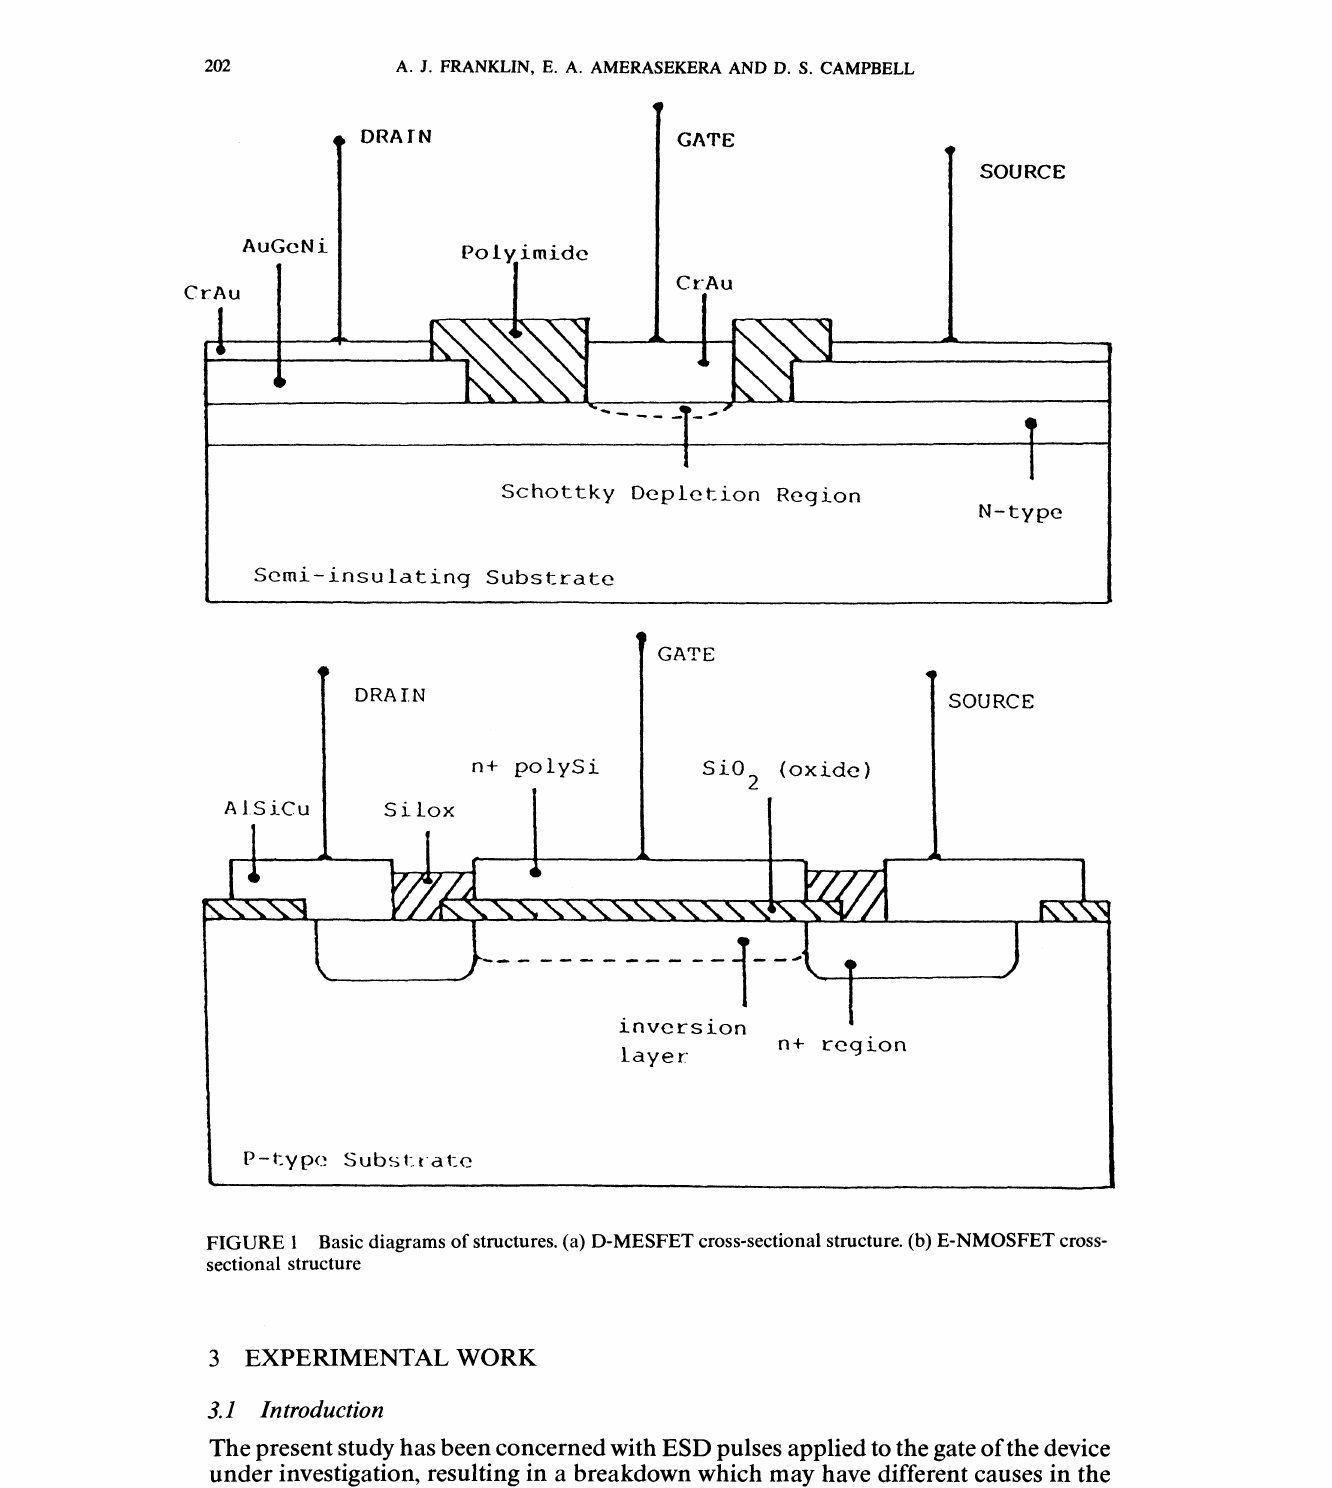
Basic diagrams of structures. (a) D-MESFET cross-sectional structure. (b) E-NMOSFET cross- sectional